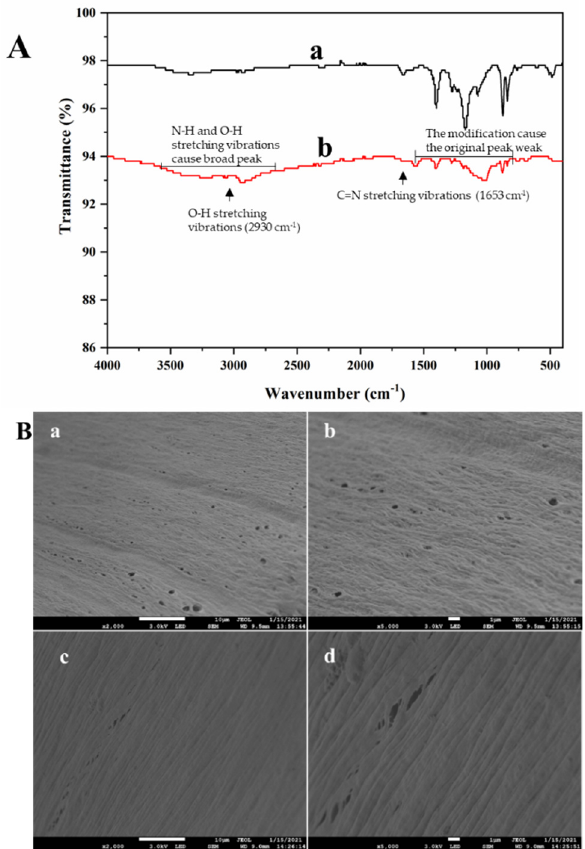
Figure 1. FT-IR spectra of hollow fiber and hollow fiber modified by PDA ( A ); (a) is hollow fiber and (b) is hollow fiber modified by PDA. SEM images of hollow fiber and hollow fiber modified by PDA ( B ); (a) and (b) are hollow fiber at 3.0 kV × 2000 and 3.0 kV × 5000, and (c) and (d) are hollow fiber modified by PDA at 3.0 kV × 2000 and 3.0 kV × 5000.